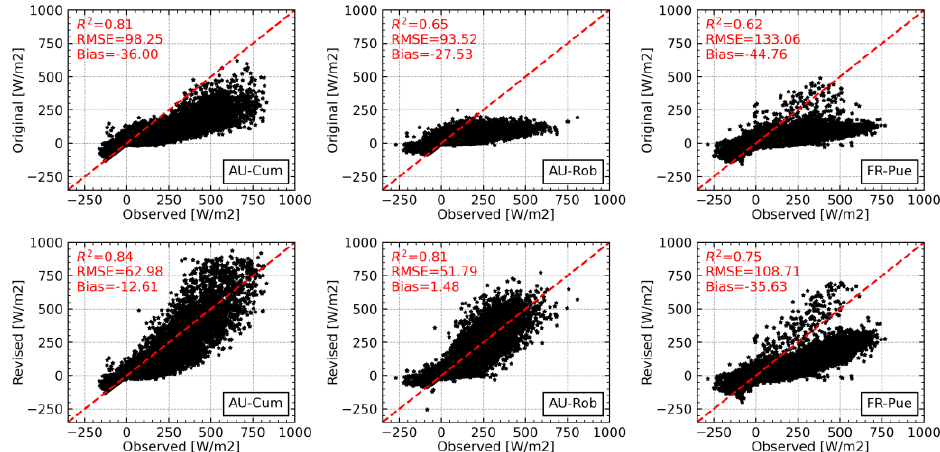
Figure 8. Relationship between the observed and simulated sensible heat flux by the original and the improved parameterization at Evergreen Broadleaf Forest (EBF) sites.